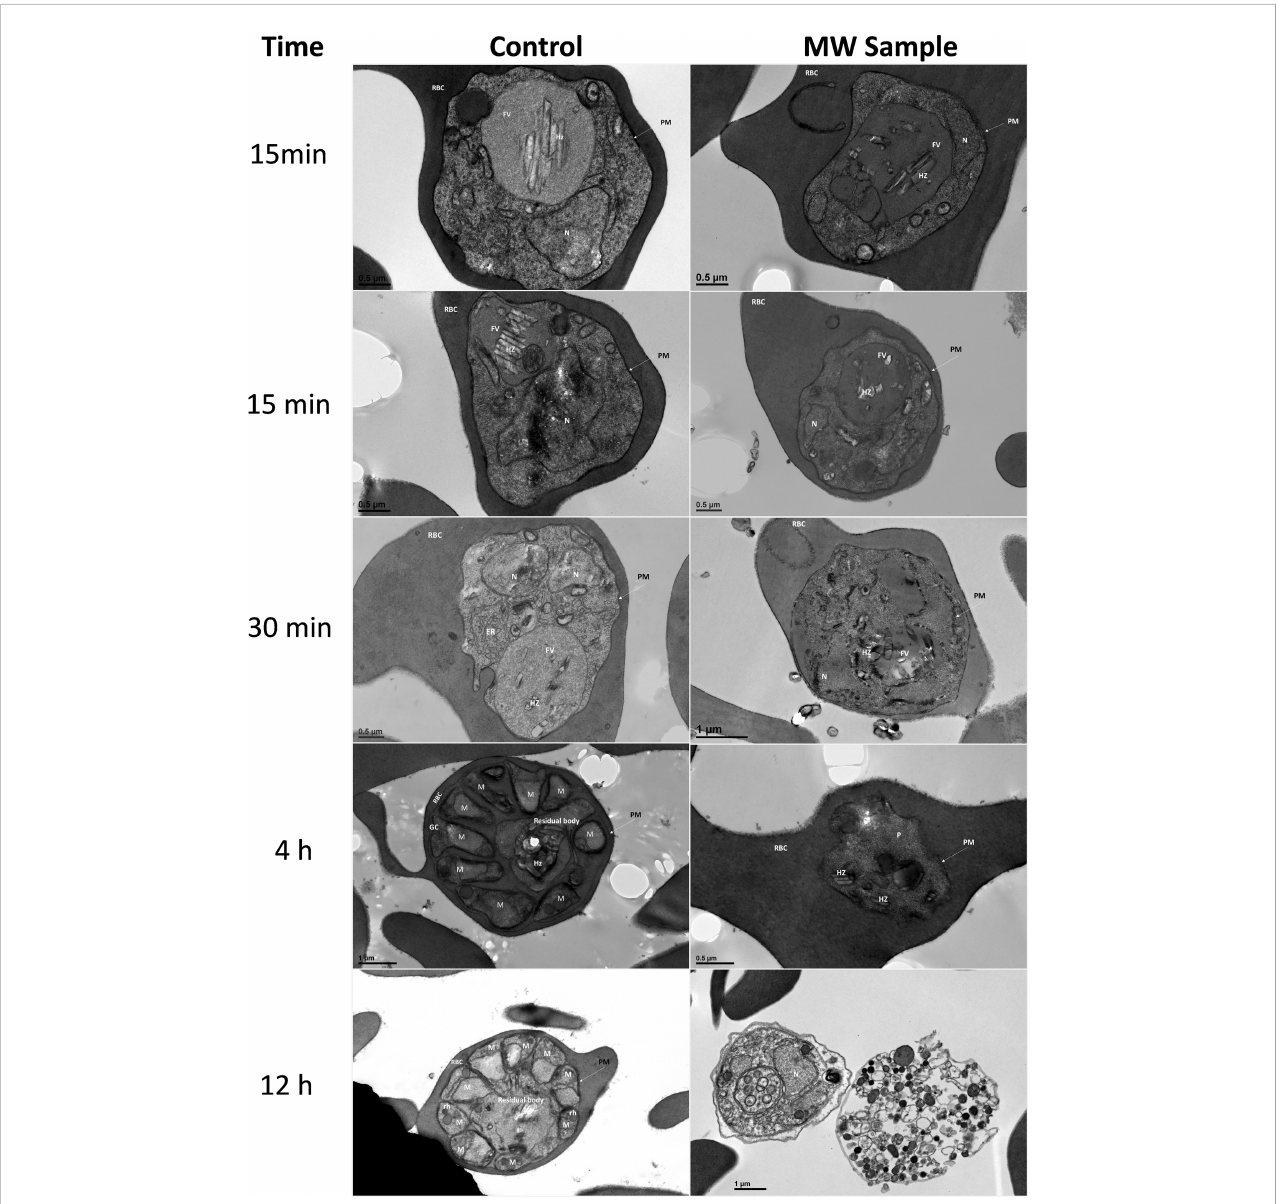
FIGURE 4 Ultrastructural changes in iRBCs after treatment with MW. MW-treated or untreated parasites were examined by transmission electron microscopy up to 12 h after MW treatment. The scale bar for Control 12 h is the same as MW sample 12 h. PM, Parasitophorous membrane; RBC, red blood cell; FV, food vacuole; HZ, haemozoin; N, nucleus; M, merozoite; Rh, rhoptry; GC, Golgi